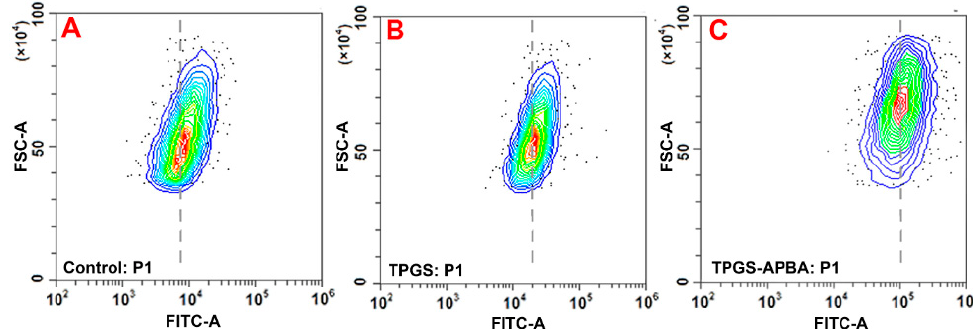
Figure 5. E ff ect of APBA attachment upon trans-cellular uptake of micelles. Shown are the FACS data for untreated cells ( A ), and those incubated with TPGS ( B ) and TPGS-APBA ( C ) micelles. The cells in ( B ) and ( C ) were incubated with FITC-loaded micelles for 4 h.